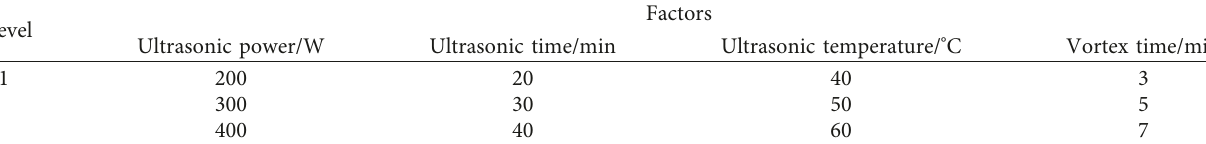
Figure 2: Investigation of single factors in ultrasonic extraction process. Table 3: Response surface test factor level of PcS extraction process.